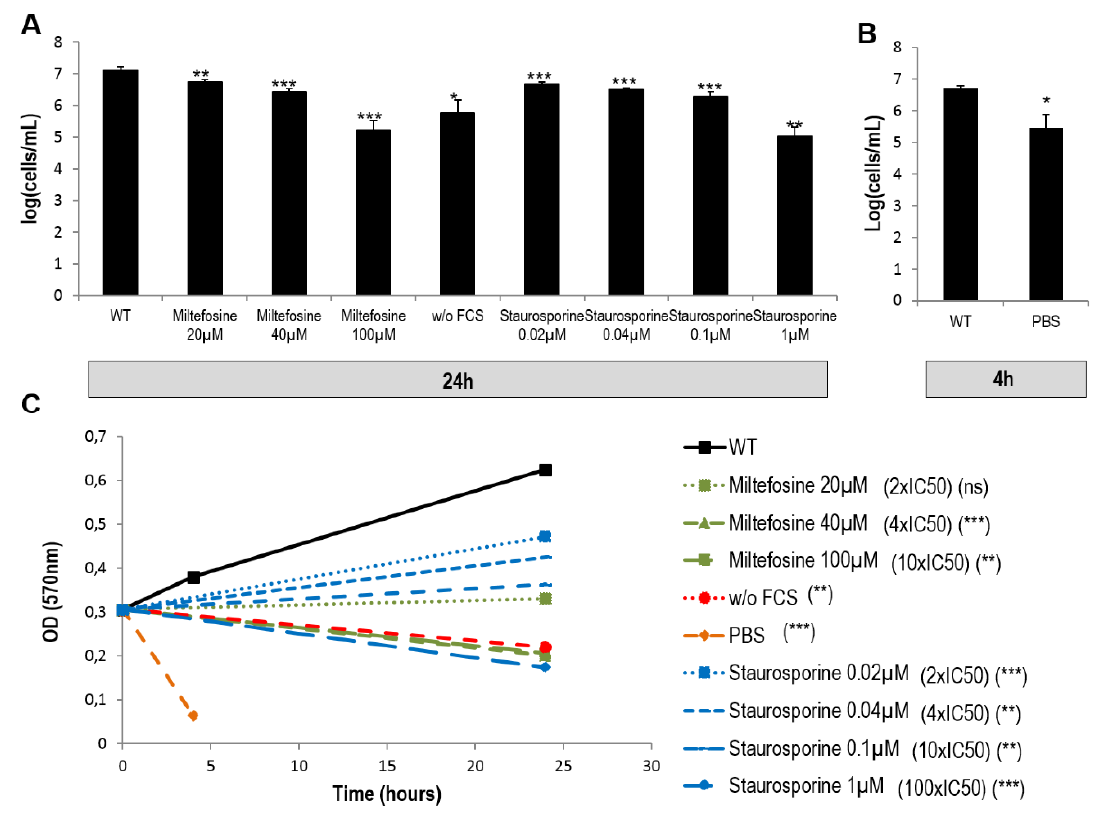
FIGURE 1: Effects on growth and culture density of miltefosine, staurosporine, PBS and of the absence of FCS. (A-B) Cell concentration after culture for 24 h in different conditions (A) or for 4 h in PBS (B) . Mean ± SD from a minimum of three independent experiments. Unpaired t- test between the condition of interest at 24 h and the control condition at 24 h. (C) Optical density of cells cultivated in different conditions after addition of MTT. A minimum of three independent experiments were carried out. Unpaired t-test between the condition of interest at 24 h or 4 h and the same condition at 0 h: ns not significant, * p < 0.05, ** p < 0.01, *** p < 0.001